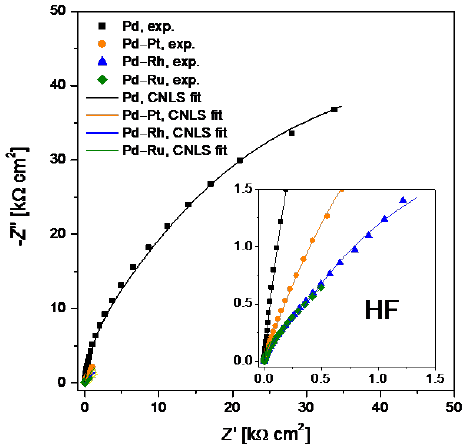
Figure 5. Complex–plane impedance plots obtained for electrodeposited Pd, Pd-Rh, Pd-Ru, and Pd-Pt electrodes in deaerated 0.5 M H 2 SO 4 at the open circuit potential. Symbols and continuous lines represent experimental data and fits obtained using the equivalent electrical circuit shown in Figure 6 respectively. The corresponding Bode plots in the form of impedance magnitude (log | Z |) and phase angle ( ) versus log frequency ( log f) are shown in Figure 7a and b, respectively. The experimental values of | Z | f → 0 and revealed that the tested electrodes were materi- lowest frequency studied indicated deterioration of the barrier properties for binary Pd– based alloys compared to the Pd electrode (Figure 7a). Bode impedance plots indicated the occurrence of two time constants in Figure 7b. A wide plateau in the mid-frequency